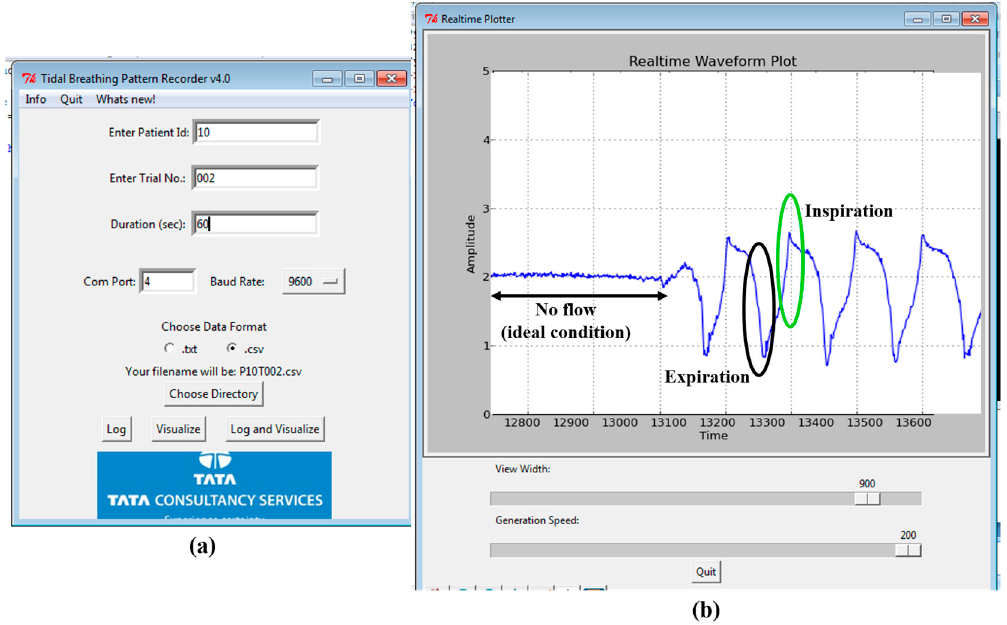
Figure 3. The custom-made TBP acquisition software interface ( a ) the initial screen to enter the subject and trial information; ( b ) the data visualization window depicting the acquired TBP waveform.